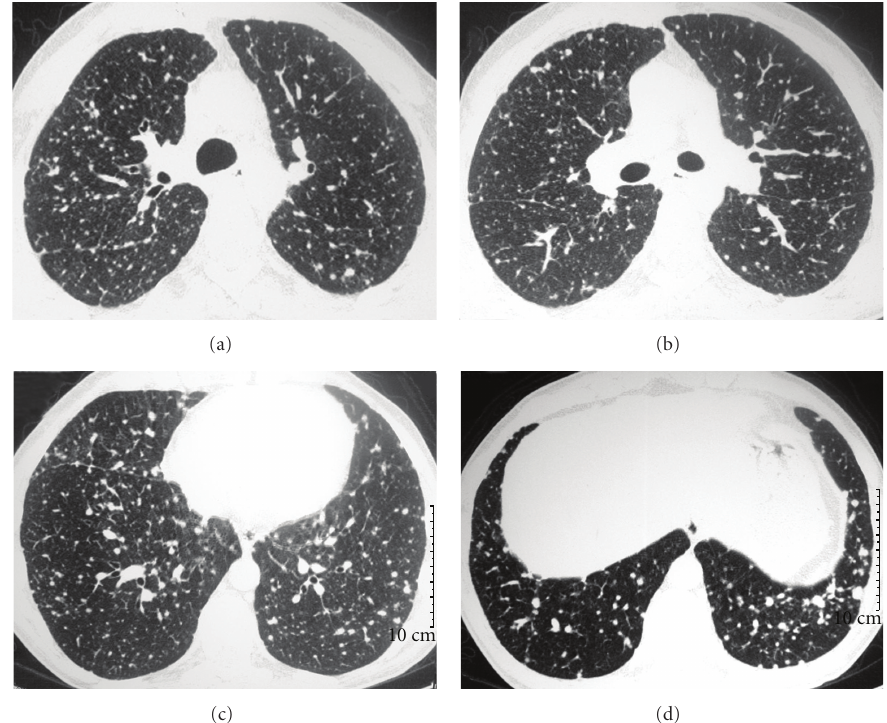
Figure 2: High-resolution CT scans at four di ff erent levels showing small nodules distributed randomly through the lungs. Note that the nodules are larger in the lung bases